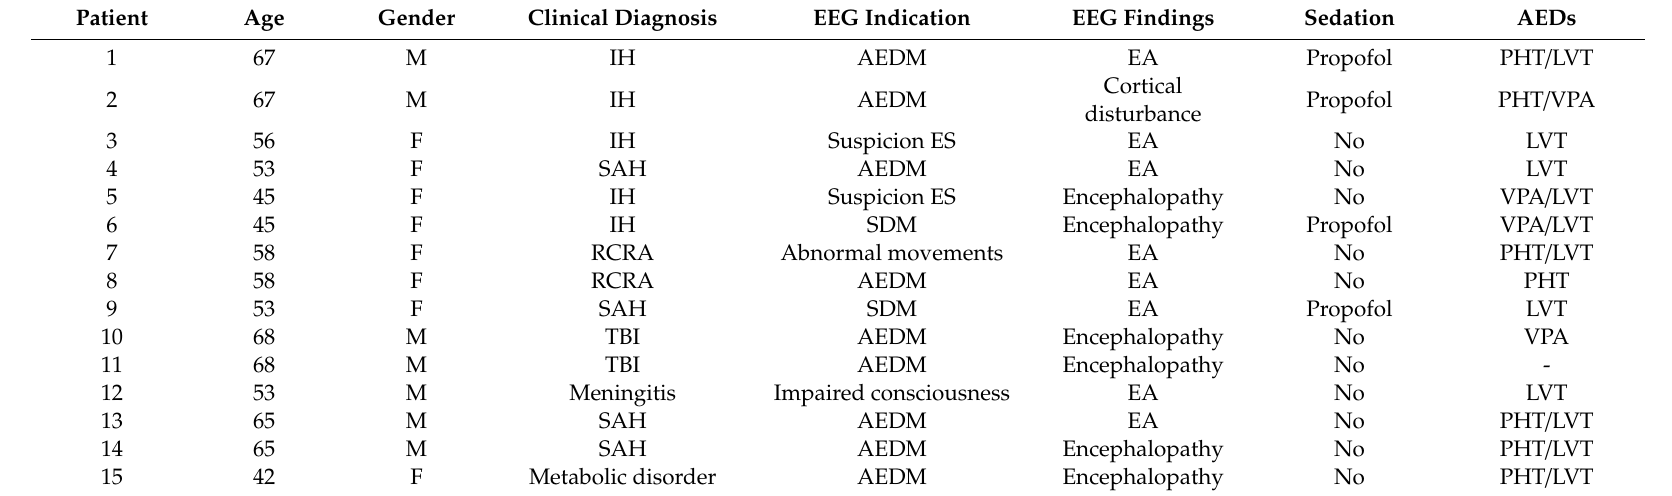
Table 1. Clinical features of patients showing bursts of periodic activity